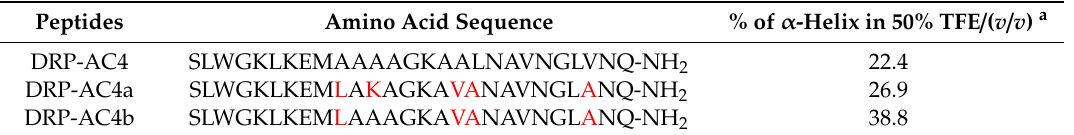
Table 2. Amino acid sequences and calculated of α -helix proportion of DRP-AC4, DRP-AC4a and DRP-AC4b.